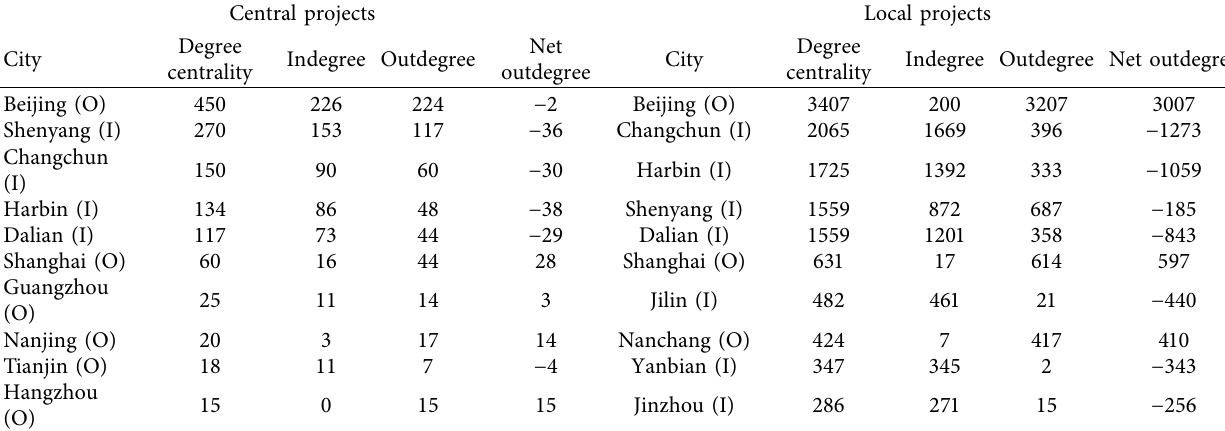
Table 7: Degree centrality of the top 10 cities in the national